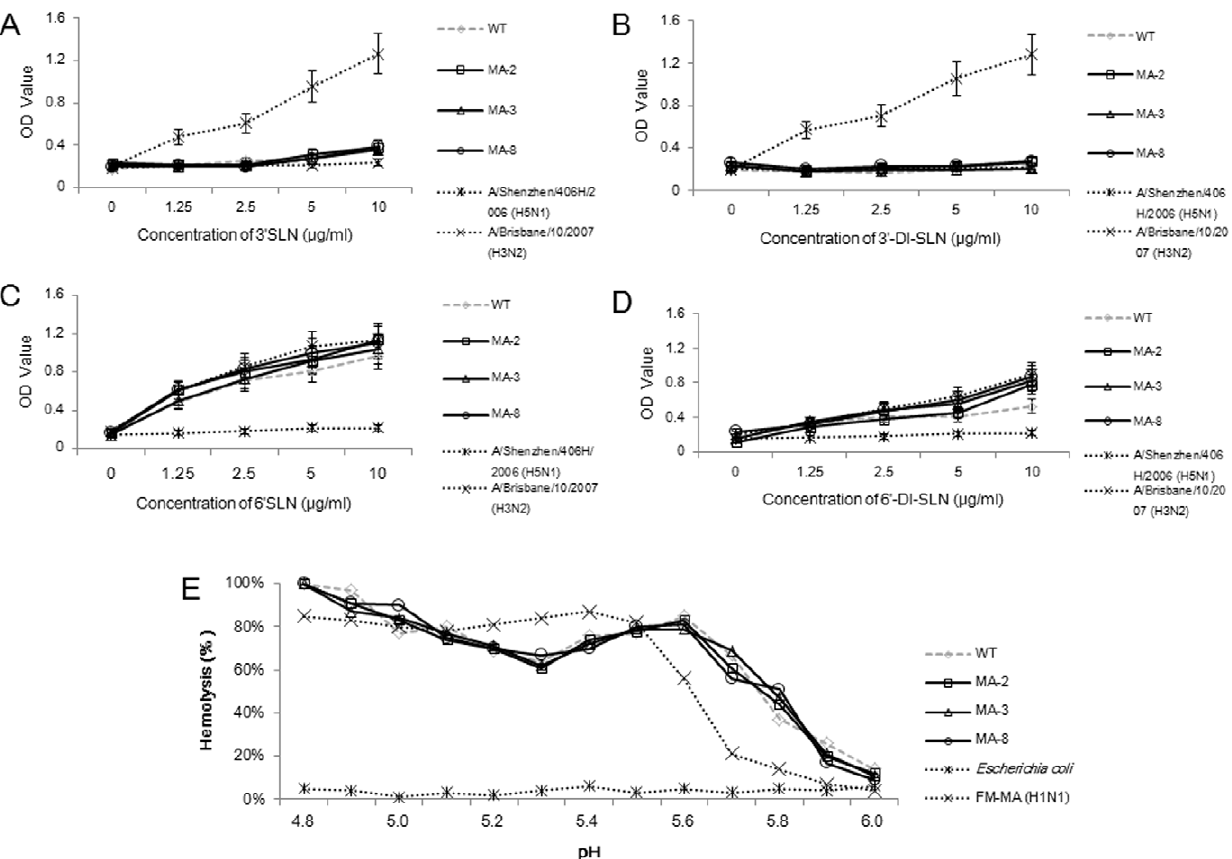
Figure 5. The mouse-adapted virus has receptor binding and pH-dependent fusion properties similar to the wild-type virus. The specificity and affinity of receptor binding and the pH-dependent hemolysis of the mouse adapted and wild-type viruses were determined by in vitro binding to the synthetic biotinylated sialylglycopolymers and pH dependent hemolysis, respectively. Data are expressed as mean 6 SD of OD values or percentage of lysing cells by each type of virus. The receptor binding profiles of A/Shenzhen/406H/2006 (H5N1) and A/Brisbane/10/2007 (H3N2) viruses, and the hemolysis profile of FM-MA (H1N1) virus and Escherichia coli are shown as controls. (A) Binding to the 3 9 SLN. (B) Binding to the 3 9 DI- SLN. (C) Binding to the 6 9 SLN. (D) Binding to the 6 9 DI-SLN. (E) The percentage of lysing cells.